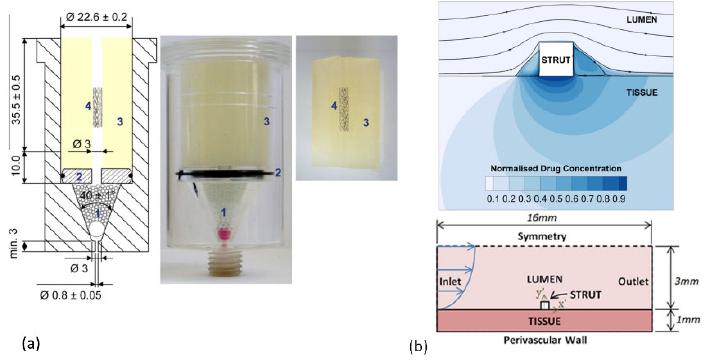
Figure 5. Different geometries of stents ( a ) cylindrical (1. Glass beads, 2. acrylic glass disc, 3. hydrogel and 4. expanded stent) and ( b ) rectangular used in different studies, reproduced with permission from [46,47]. Reproduced with permission from Anne Seidlitz, Stefan Nagel, Beatrice Semmling, Niels Grabow, Heiner Martin, Volkmar Senz, Claus Harder, Katrin, Sternberg, Klaus-Peter Schmitz, Heyo K. Kroemer,Werner Weitschies, Examination of drug release and distribution from drug ‐ elutingstents with a vessel ‐ simulating flow ‐ through cell; published by Elsevier, 2011.